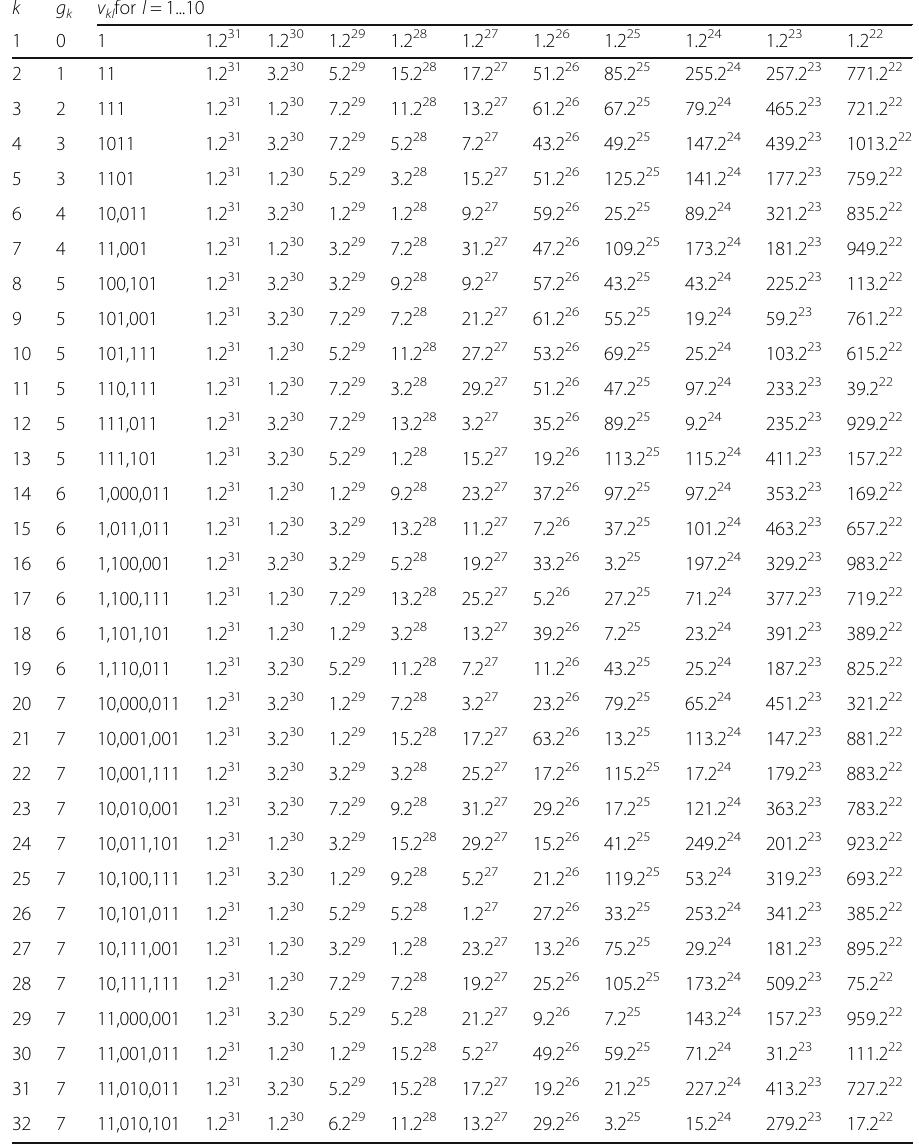
Table 9 An instance of the initialisation numbers for generating Sobol ’ s LDS, up to a dimension of 32 (Jäckel